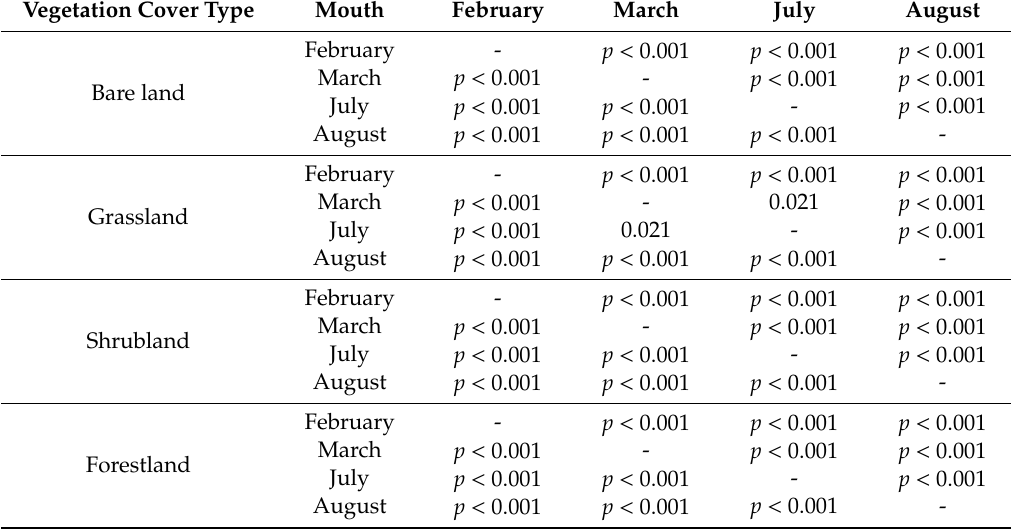
Table 5. Comparison of soil moisture content data in different mouths based on the Mann–Whitney’s U test with Bonferroni correction under different vegetation cover types ( p -value).